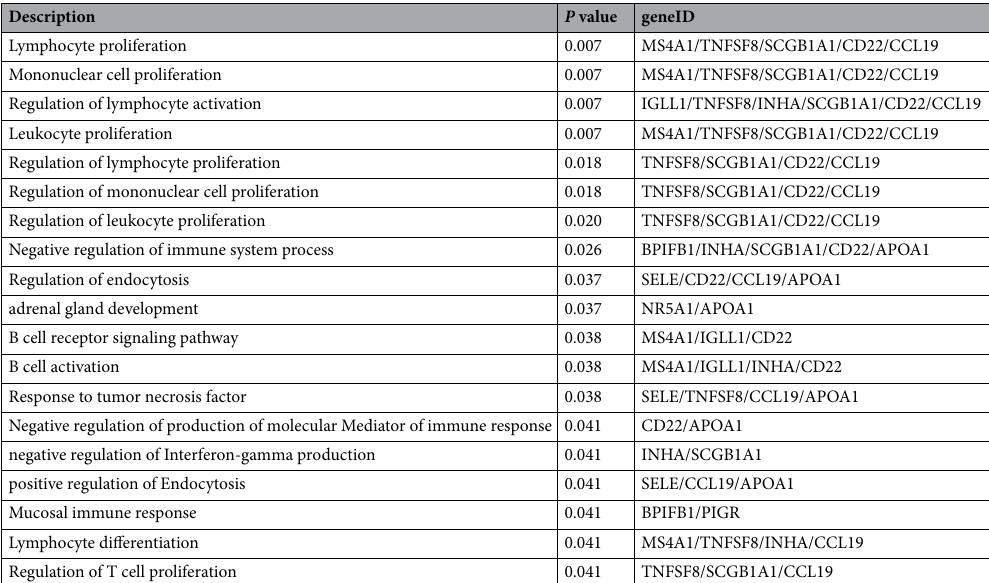
Table 3. GO enrichment analysis of TMB associated DEGs in